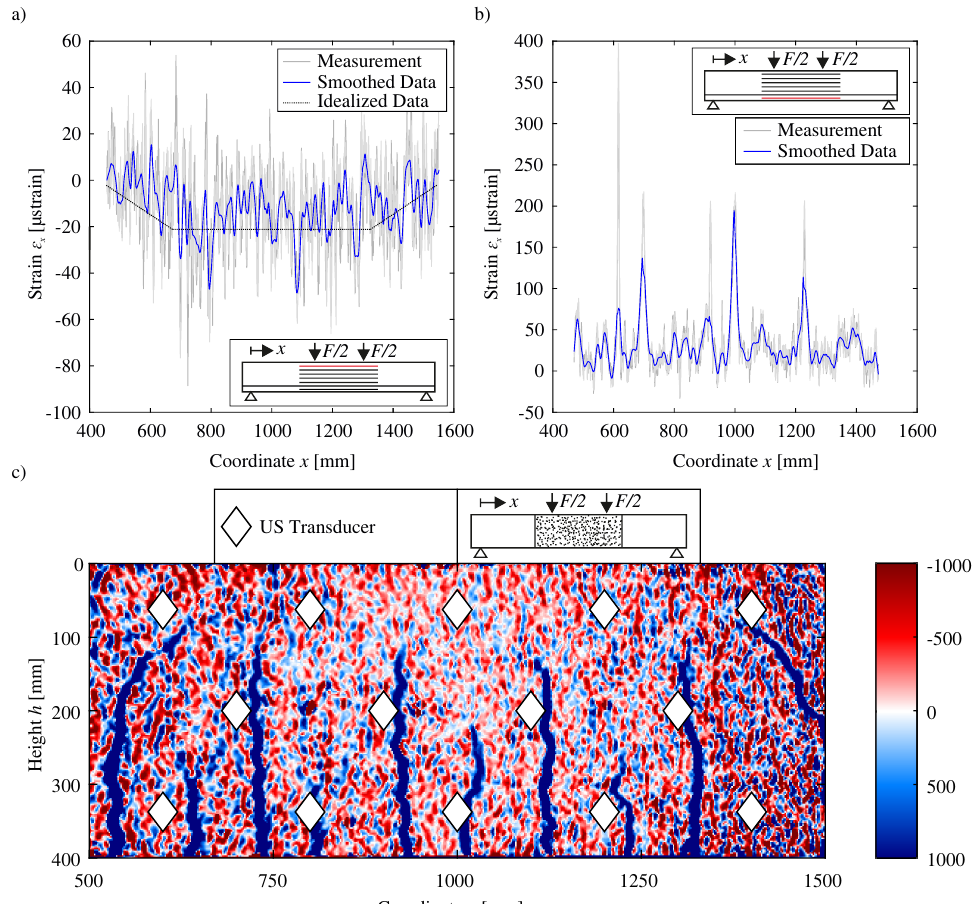
Figure 7. ( a , b ) Strain from Fiber Optic Sensors (FOS) for an applied load of F = 10kN and ( c ) strain from Digital Image Correlation (DIC) for an applied load of F = 160kN and marked US transducer